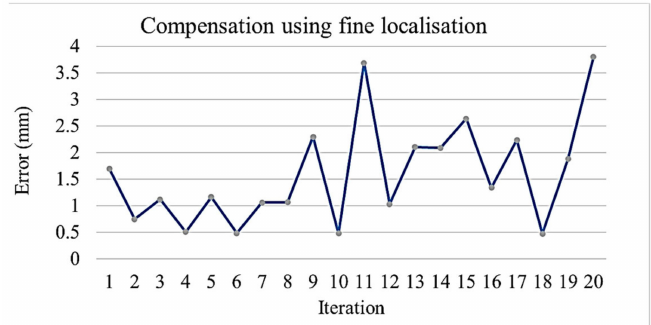
Figure 11. Positionin error after compensation using fine localisation in 20 repeat experiments.